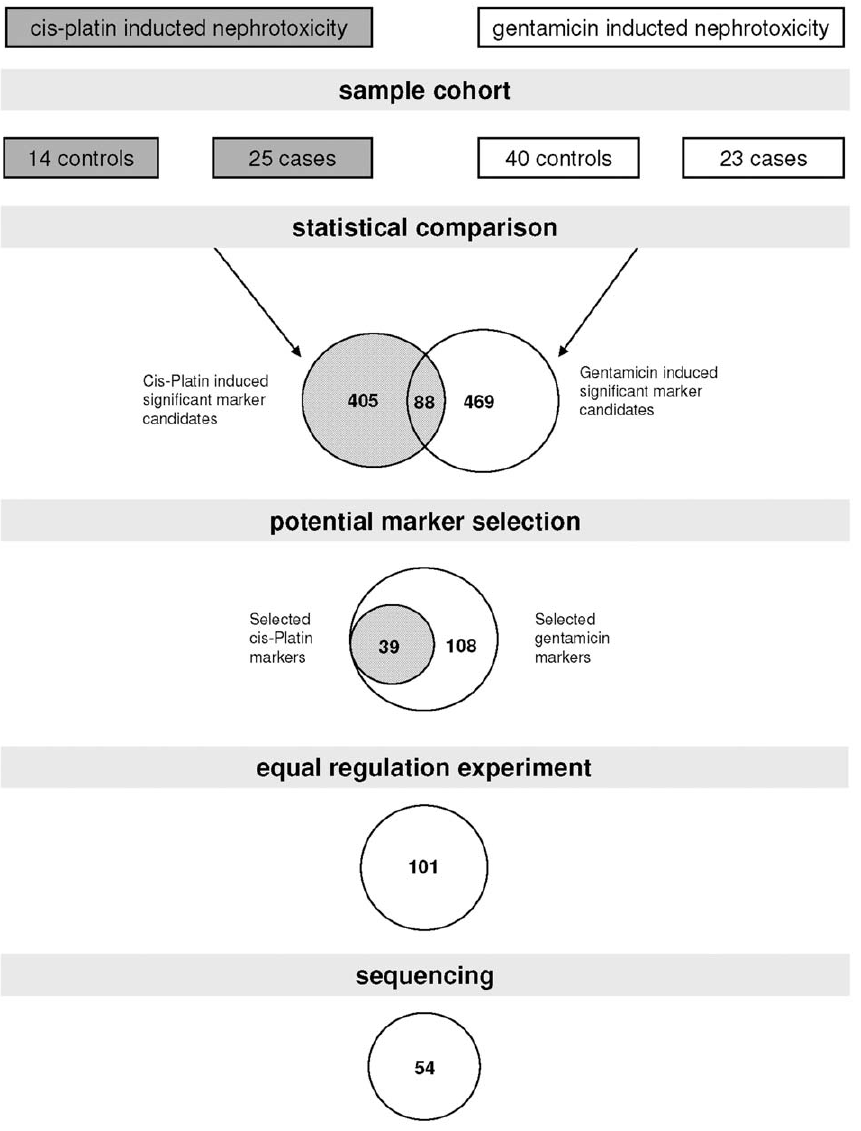
Figure 1. Study design and rationale for biomarker selection. Depicted is the size of the sample cohorts used in the biomarker definition step and the number of selected peptides after statistical comparison of the respective treated and control groups. Numbers of peptides identified in both cis-platin and genatmicin treated rats as markers are denominated in the intersection of the diagrams. The significant marker candidates were visually inspected and only those candidates were selected that showed a clear response to gentamicin. In the next step the direction of regulation was controlled for the markers identified in both studies and selected were only those demonstrating similar (up or down) regulation with both cis-platin and gentamicin. In the last step the number of markers for which the amino acid sequence could be resolved is listed.